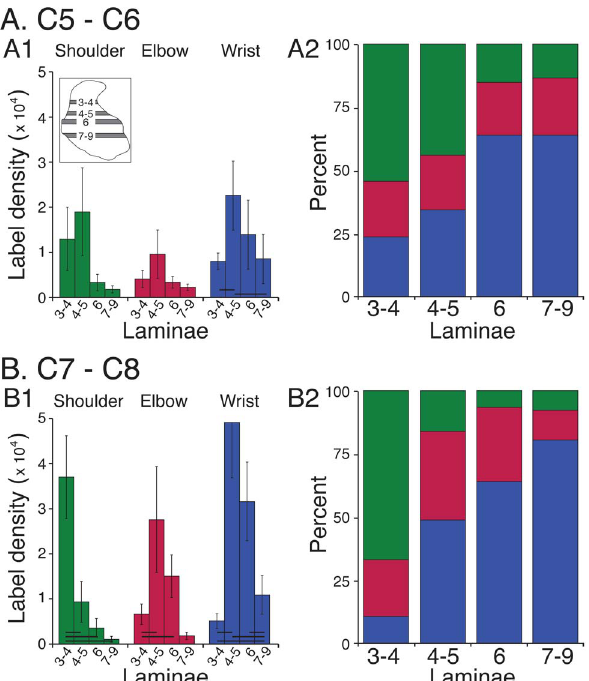
Figure 4. Density of CST anterograde label at 4 dorsoventral levels. A. C5/C6. B. C7/C8. Each row plots average label for ROI (inset, A2) from medial to lateral. Inset. Scale bars: 500 m m; 2.5 density units.